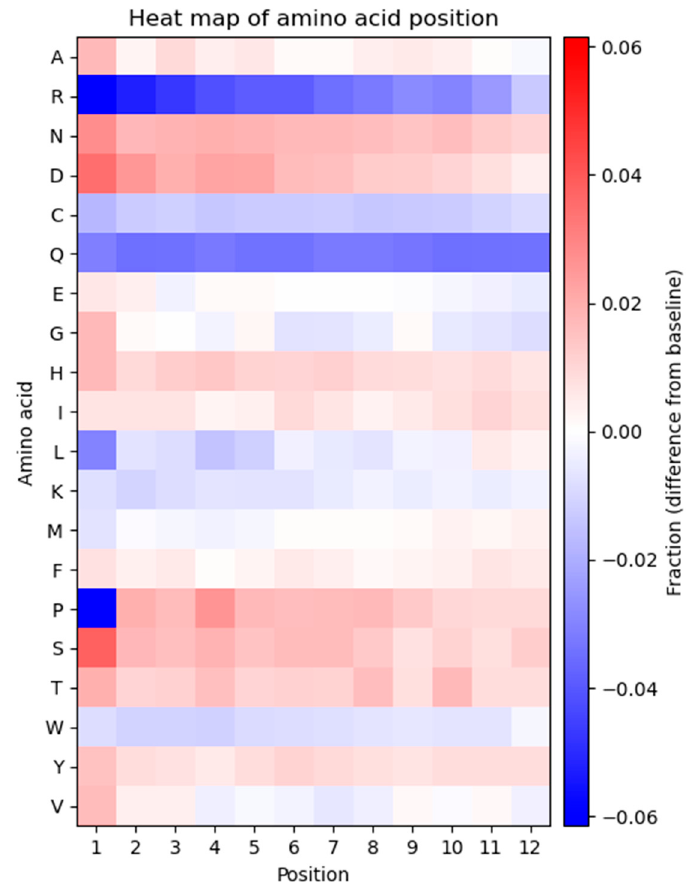
Figure 4. Heatmap showing the positional frequency of every amino acid in each position throughout the displayed peptide compared to the expected frequency, calculated based on the codons available. Overrepresented amino acids (red) and underrepresented amino acids (blue) according to the expected frequency are shown in the heatmap.